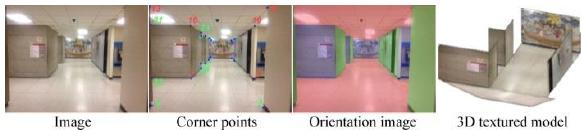
Figure 2. From left to right: sample image from dataset, identified layout corner points, ground truth orientation image and the respective 3D textured